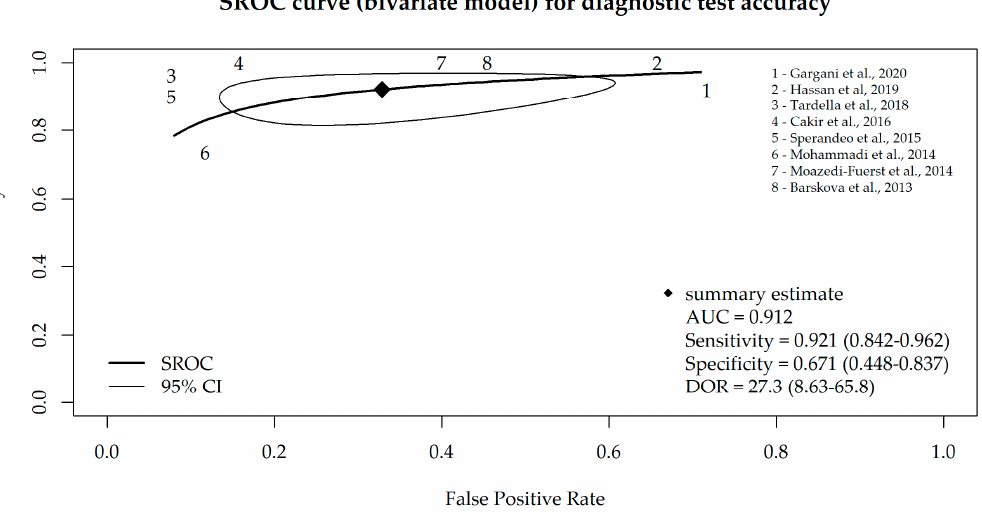
Figure 2. Forest plots for univariate random-effects meta-analyses showing ( A ) specificity and ( B ) sensitivity of LUS, based on eight studies that used B-lines as a criterion for ILD diagnosis [17–24]. Taking into account that the specificity and sensitivity of a diagnostic test are mutu- ally dependent, we additionally performed a bivariate meta-analysis, and the SROC curve is depicted in Figure 3. The AUC value of the SROC curve was 0.912 (and 0.917 in consid- eration of all nine studies), which indicates high sensitivity and a low false-positive rate for the majority of the included studies.